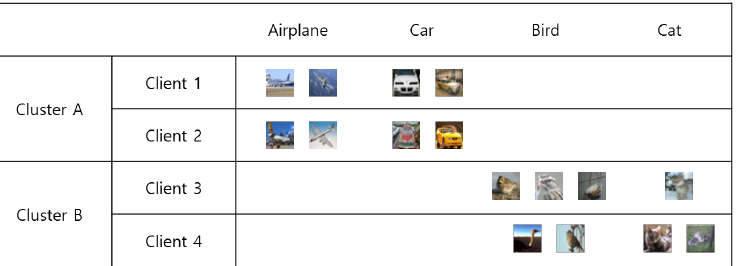
Figure 1. ResNet-based network architecture used in experiment. An illustrative example of label-size imbalanced non-IID. The clients in the first cluster A only has airplane and car data. The clients in the second cluster B only has bird and cat data. The number of each class samples may vary for each client, however, the total number samples are the